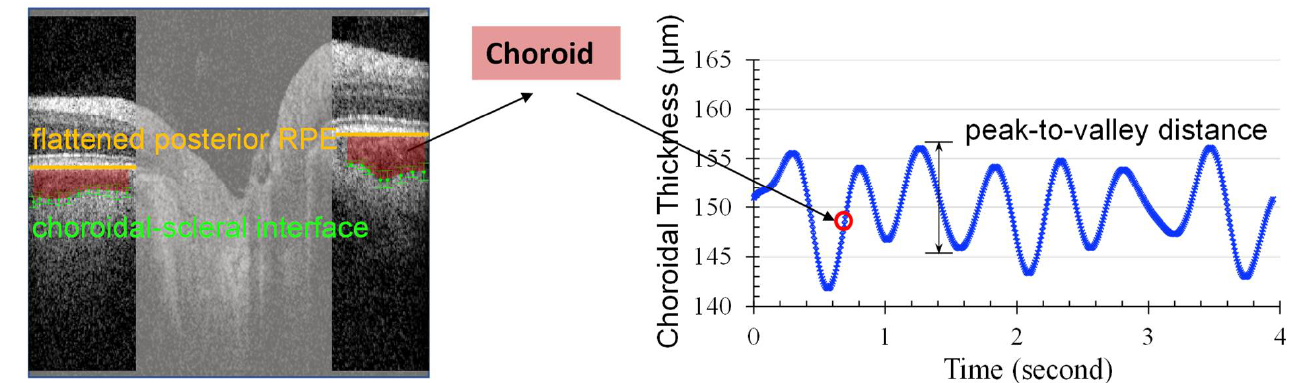
Figure 2. The framework of estimating the pulsatile change in choroidal thickness. The optic nerve region was excluded from the region of interest, and the posterior retinal pigment epithelium (RPE) of each side of the optic nerve was flattened before the segmentation of the choroidal–scleral interface. The average distance between the posterior RPE (i.e., the retinal-choroidal interface) and the choroidal–scleral interface was calculated as the choroidal thickness for a certain frame. The average peak-to-valley distance in the filtered choroidal thickness waveform was calculated as the pulsatile change in choroidal thickness.